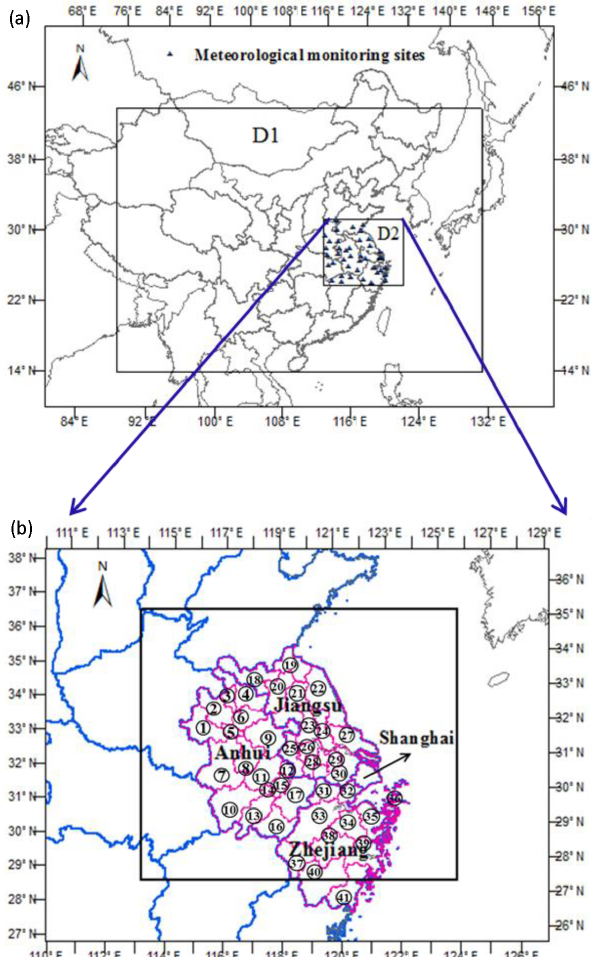
Figure 2. Model domain and locations of 43 meteorologi- cal monitoring sites. The numbers of 1–41 represent the